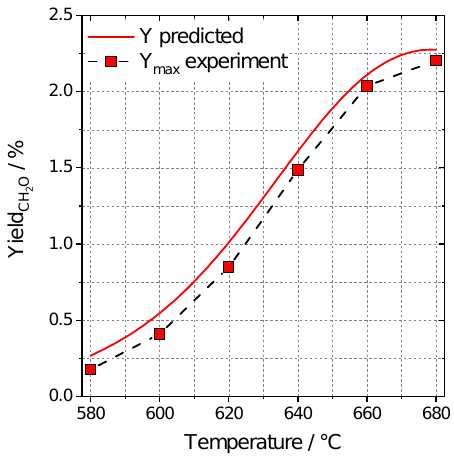
Figure 7. Predicted and experimental yield at 600,000 L · kg − 1 · h − 1 , 20% O 2 , 50% N 2 and 20% H 2